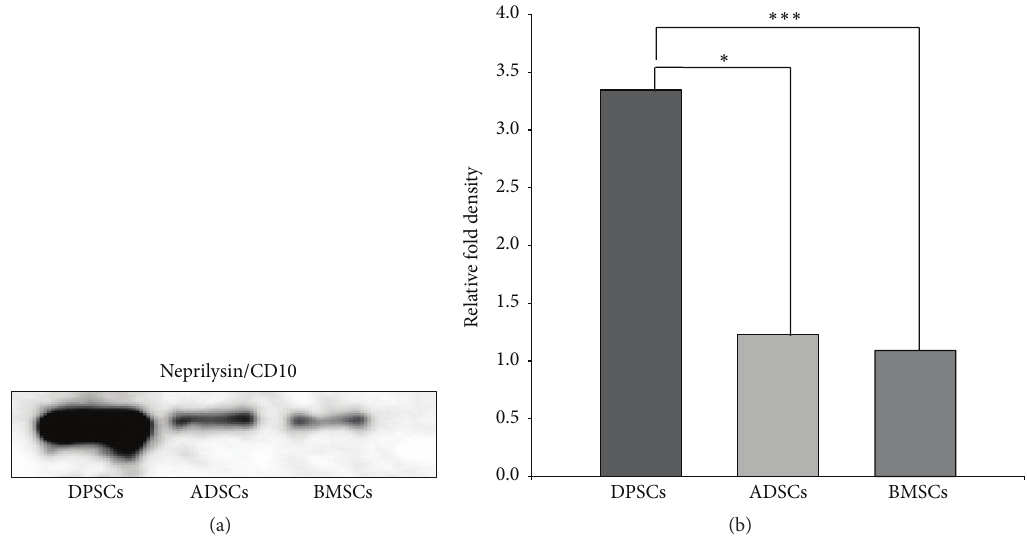
Figure 5: DPSC secretome contains a higher concentration of neprilysin/CD10. (a) Immunoblotting analysis with an anti-NEP antibody (full-length blots are presented in Supplementary Figure S3). (b) Relative fold density as analyzed by Image J (mean ± SE, 𝑛 = 3 . ∗ 𝑝 < 0.05 , ∗∗∗ 𝑝 < 0.001